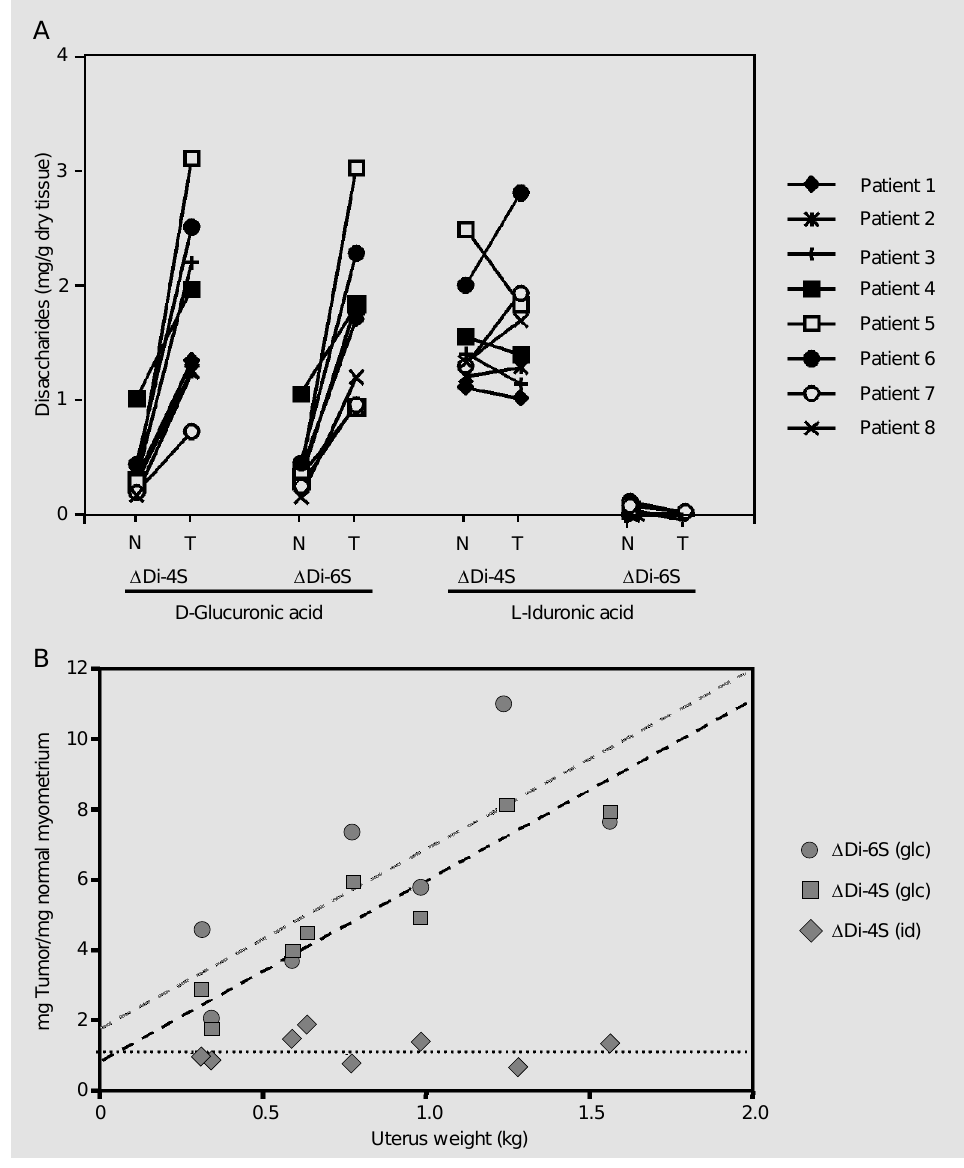
Figure 2. Disaccharide composition of galactosaminoglycan from normal human myometrium (N) and leiomyoma (T). A , Concentration of unsaturated disaccharides produced by bacterial chondroitinases AC (D-glucuronic acid) and ABC (L-iduronic acid): incubation mixtures containing 30 µg of glycosaminoglycans and 20 x 10 -3 U of either Flavobacterium heparinum chondroitinase AC or Proteus vulgaris chondroitinase ABC were prepared in 0.1 M ethylenediamine-acetate buffer, pH 7, in 30 µl final volumes. After overnight incubation at 37 o C, the mixtures were applied to Whatman No. 1 filter paper and submitted to descending chromatography in isobutyric acid: 1.25 M NH 4 OH, 5:3 (v/v). Reducing products were stained with alkaline silver nitrate (17). The disaccharides that contain D-glucuronic acid were estimated by densitometry of the disaccharides produced by the chondroitinase AC and the disaccharides that contain L-iduronic acid were estimated by the difference between the products formed by chondroitinase ABC and AC. D Di-4S: Unsaturated 4-sulfated disaccharides; D Di-6S: unsaturated 6-sulfated disaccharides. B , Correlation between tumor size and concentration of D-glucuronic acid-containing (circles and squares) and L-iduronic acid-containing (lozenges) disaccharide units in galactosaminoglycans. The values are reported as the leiomyoma/normal myometrium ratio. D Di-6S (glc): unsaturated 6-sulfated disaccharides produced from D- glucuronic acid-containing disaccharide units; D Di-4S (glc): unsaturated 4-sulfated disaccharides produced from D-glucuronic acid-containing disaccharide units; D Di-4S (id): unsaturated 4-sulfated disaccharides produced from L-iduronic acid-containing disaccharide